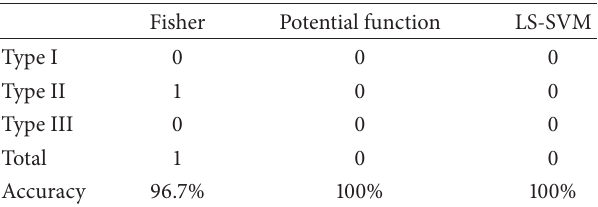
Figure 9: Clustering results obtained by AKM. Table 4: Number of misclassification of various discriminant methods under electrofacies